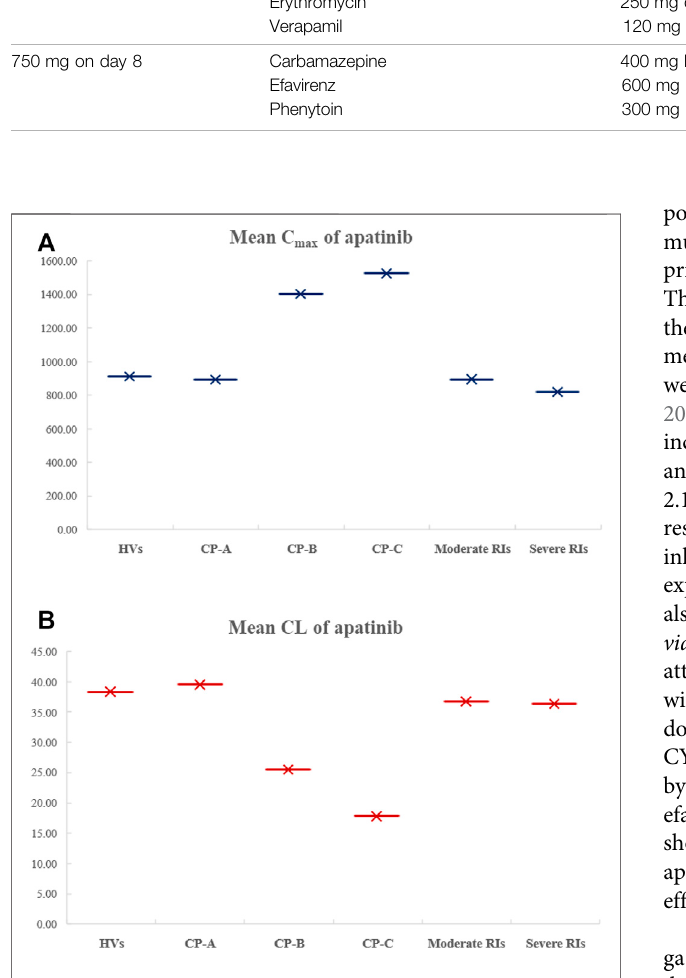
FIGURE 6 | Comparison of the simulated mean C max (A) and CL (B) of apatinib in HVs, in HIs with Child – Pugh A, B, or C, as well as in moderate and severe RIs.